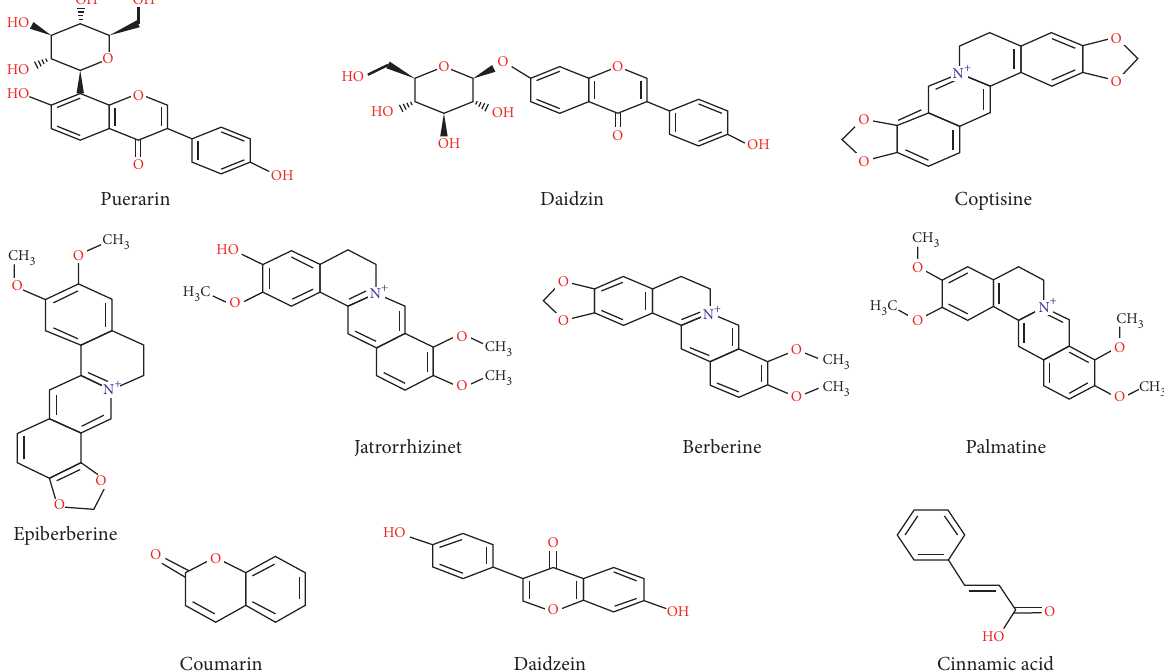
Figure 1: Chemical structures of 10 standard reference compounds in